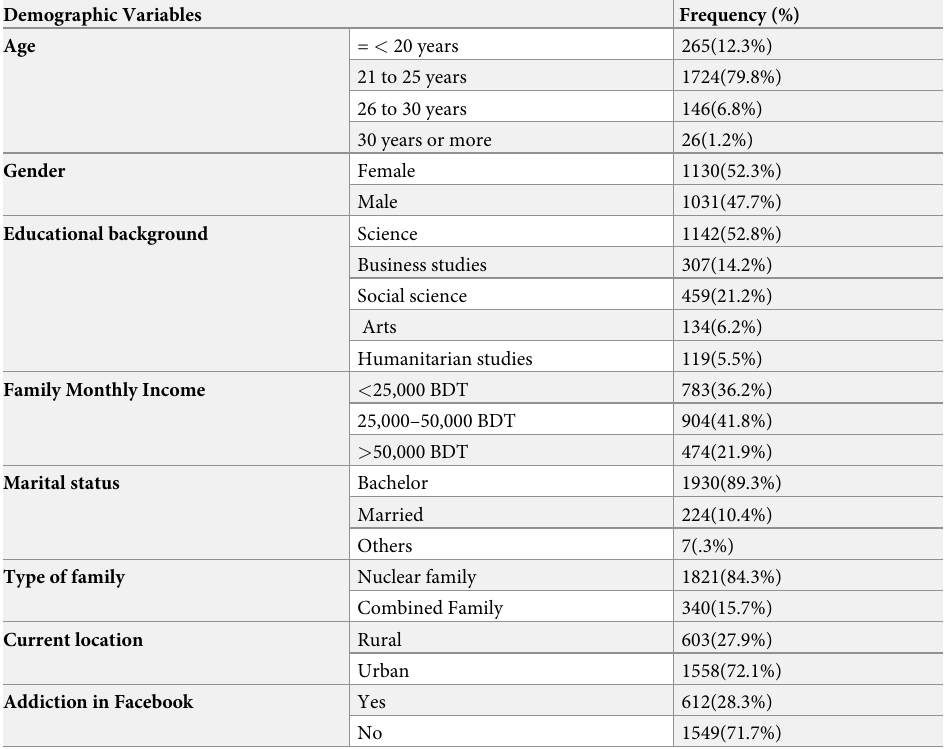
Table 1. Prevalence demographic